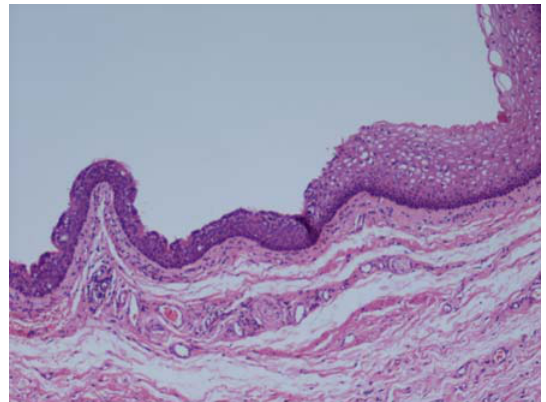
FIGURE 3. Cyst lining showing transition from multilayered ciliated epithelium (left) to mature nonkeratinizing squamous epithelium. Magnification × 100.